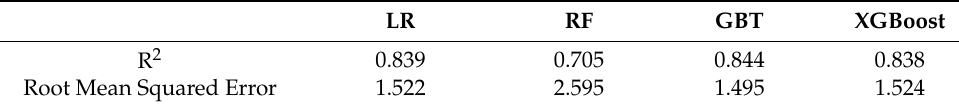
Table 5. Effectiveness performances of each regression model.